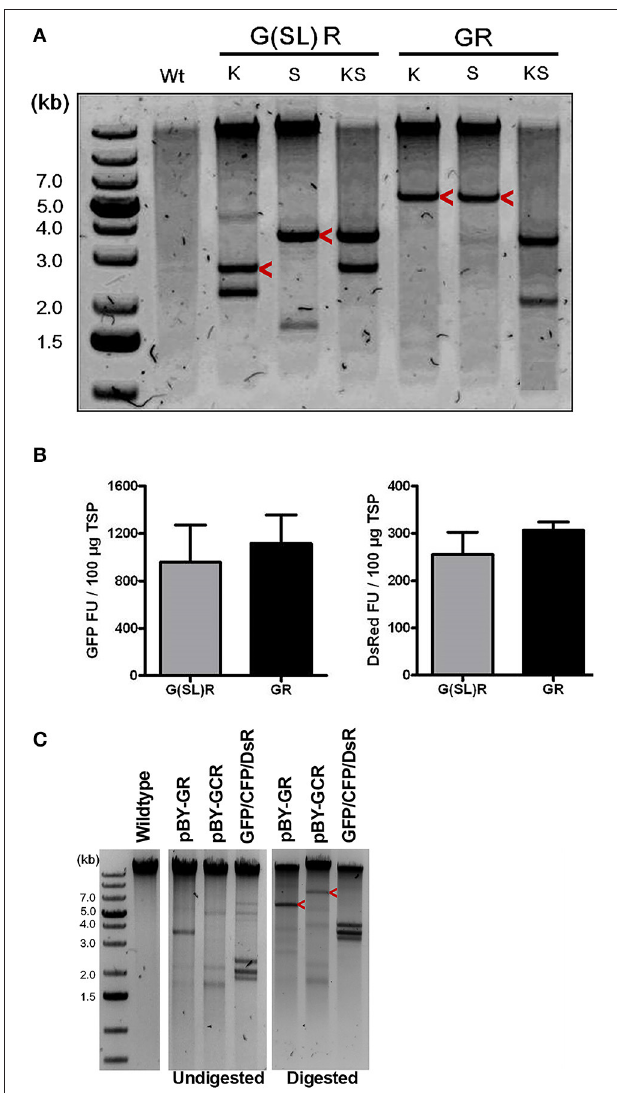
FIGURE 3 | The role of replicon size and configuration in expression and replication of BeYDV vectors. (A) Leaf DNA was extracted at 3 DPI from uninfiltrated (Wt), or samples infiltrated with the indicated vectors, then digested with indicated restriction enzymes (K, KpnI; S, SacI) and run on a 1% agarose gel. G(SL)R refers to pBY-G(SL)R; GR refers to pBY-GR. Replicon positions are indicated with arrow head. (B) Fluorimetric analysis of GFP and DsRed accumulation showing efficient co-expression of two fluorescent proteins from either single [pBY-GR] or dual [pBY-G(SL)R] replicon vectors. Dilutions of total soluble protein extracts were subjected to spectrofluorimetry using excitation and emission wavelengths of 485 and 538nm for GFP, and 544 and 590nm for DsRed. G(SL)R, pBY-G(SL)R; GR, pBY-G(SL)R. Data are means ± S.D. from three independently infiltrated samples. (C) DNA from leaves of uninfiltrated (Wt), or infiltrated with indicated vectors were separated on 0.8% agarose gels before and after restriction enzyme digestion. GFP + CFP + DsRed indicates co-infiltrated sample with Agrobacterium mixture of pBY-GFP, pBY-CFP, and pBY-DsRed. Restriction enzyme XhoI was used for pBY-GR and GFP + CFP + DsRed. For pBY-GCR, restriction enzyme SalI was used. Expected replicon positions are indicated with arrow